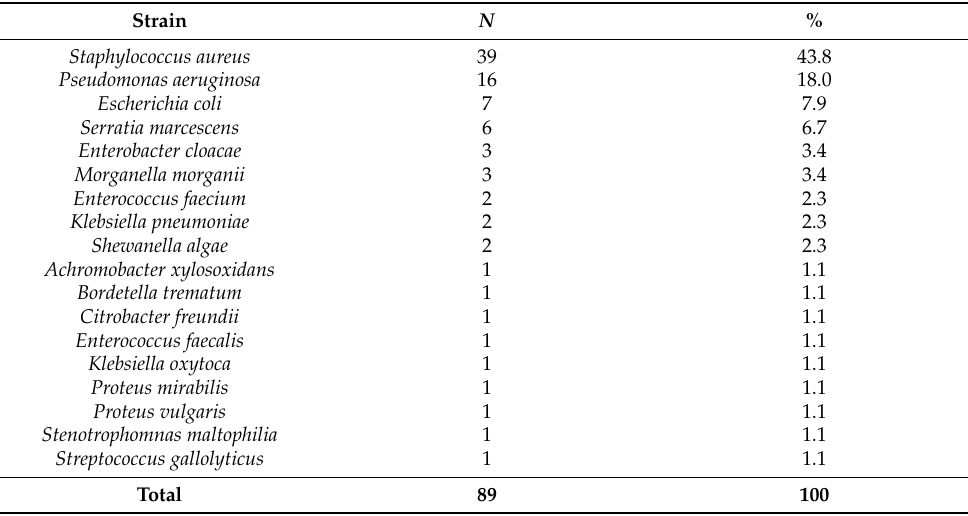
Table 2. Bacterial isolates from patients with colonized skin